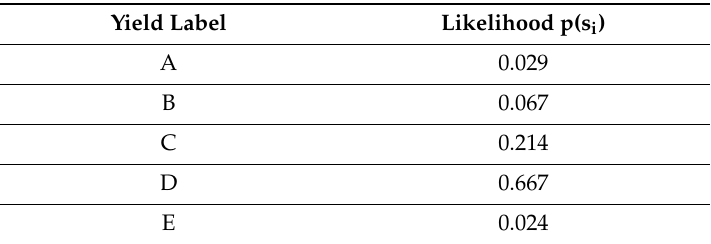
Table 5. Statistics of crop yield for Olive Farms in Crete.